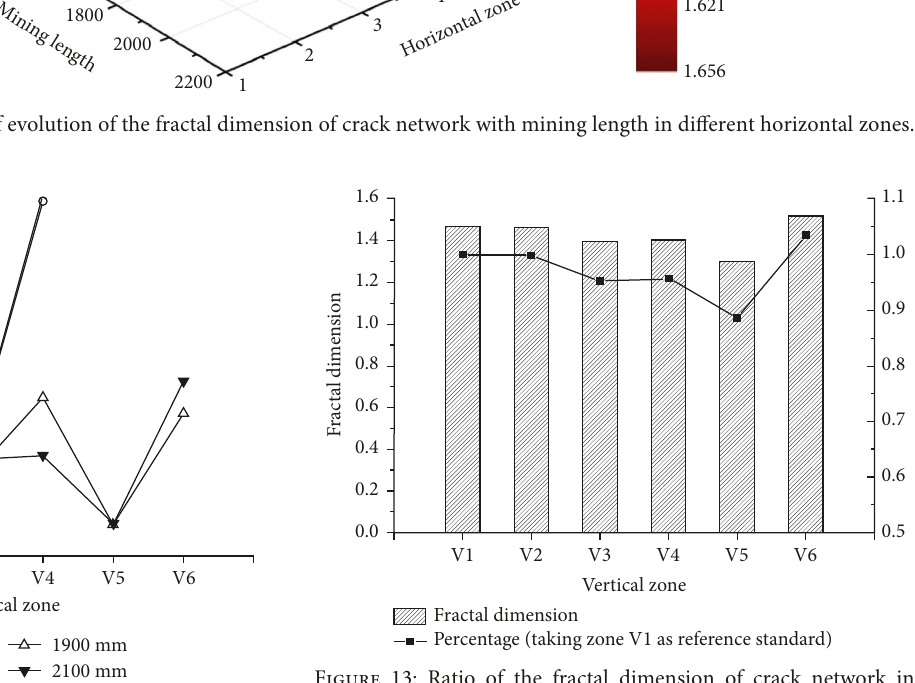
Figure 12: Evolution of the fractal dimension of crack network in different vertical zones.